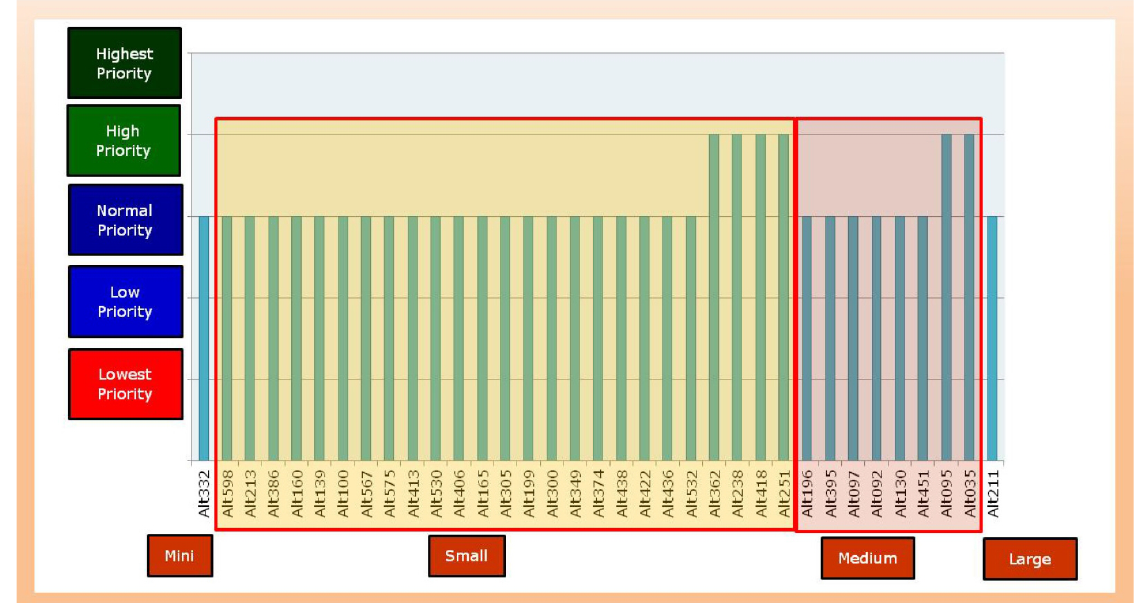
Figure 4. The overall results of the